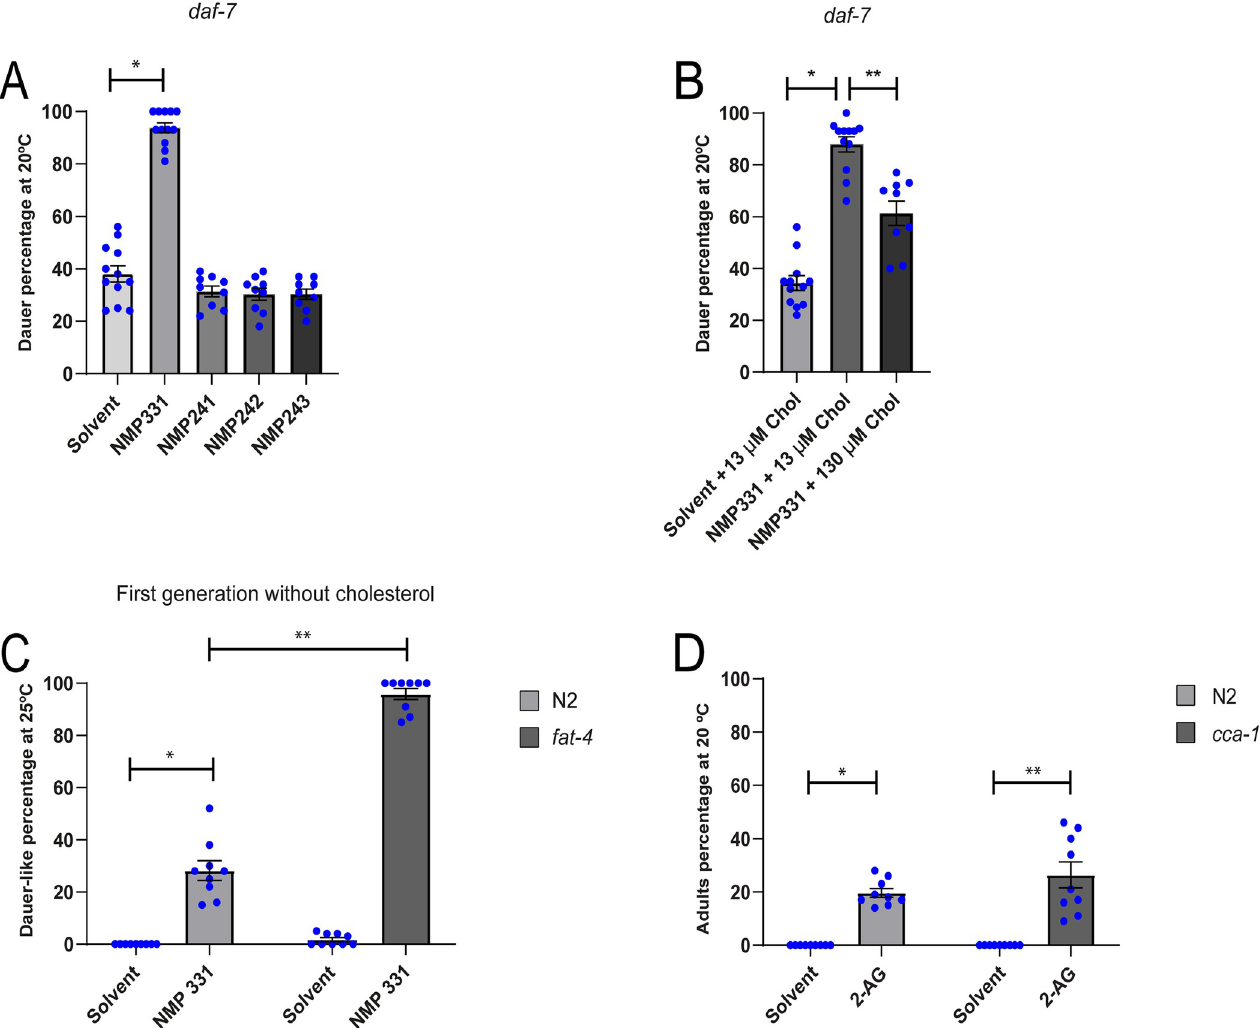
Fig 4. The cannabinoid receptor antagonist NMP331 induces dauer formation. (A) The dauer arrest of daf-7 worms is augmented by NMP331. All pairwise are multiple comparison procedures (Holm-Sidak method), � p < 0.001. All values are from n � 3 independent experiments are shown as Mean ± SEM. (B) Dauer arrest induced by NMP331 can be rescued by high cholesterol diet. All Pairwise are Multiple Comparison Procedures (Holm-Sidak method), � p < 0.001. �� p < 0.001. All values are from n � 3 independent experiments shown as Mean ± SEM. (C) N2 and fat-4 animals undergo a dauer-like arrest induced by NMP331 in the first generation when grown in cholesterol free medium. Mann-Whitney rank sum test, � p < 0.001. �� p < 0.005. All values are from n = 3 independent experiments are shown as Mean ± SEM. The concentration of NMP331 was 50 μ M. (D) The 2-AG mediated suppression of L2 � arrest of N2, grown for two generations in medium devoid of cholesterol, is independent of CCA-1. Mann-Whitney rank sum test, � p < 0.001. t-test, �� p < 0.001. All values are from n = 3 independent experiments shown as Mean ± SEM. N2 is the C . elegans wild-type strain.